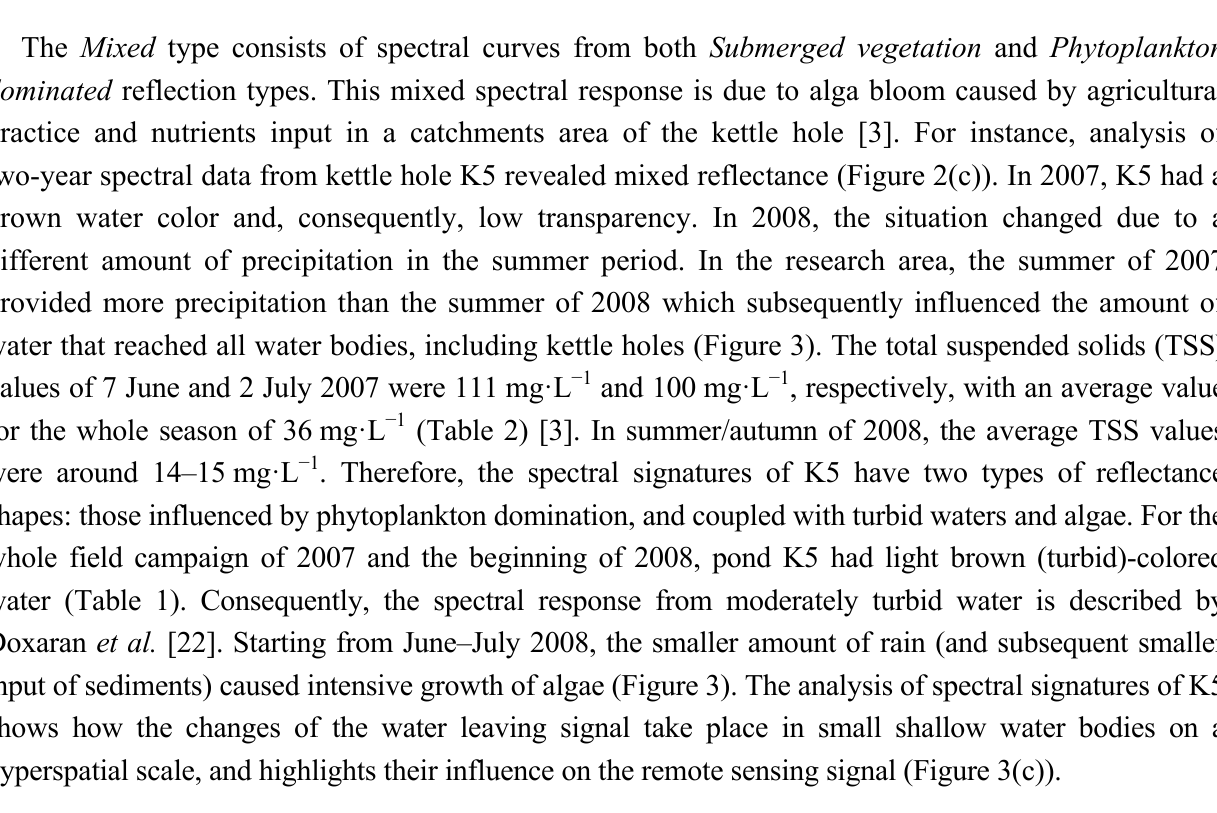
Table 2. Chlorophyll-a (P1 in μ g · L − 1 ), total chlorophyll (P2 in μ g · L − 1 ) and total